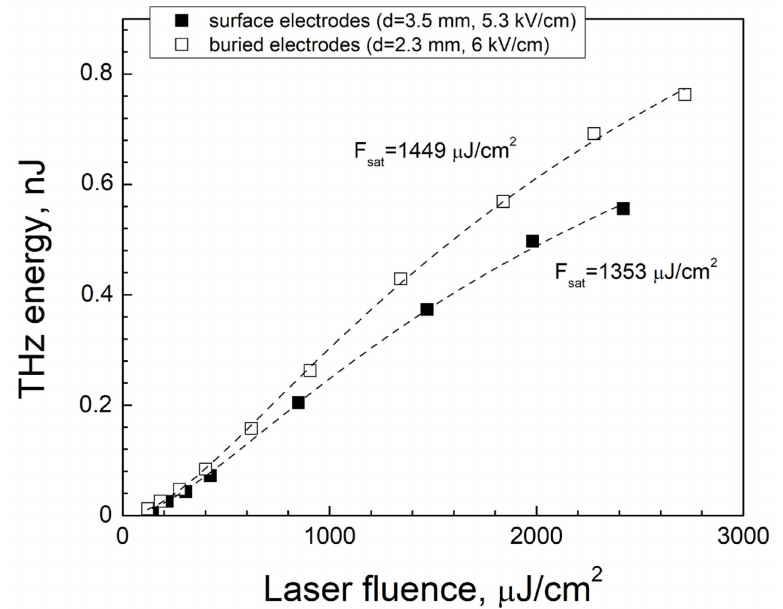
Figure 3. Experimental dependencies of THz pulse energy on laser fluence for PCAs with surface and buried electrodes. Fitting curves according to Equation (1) are shown by dashed